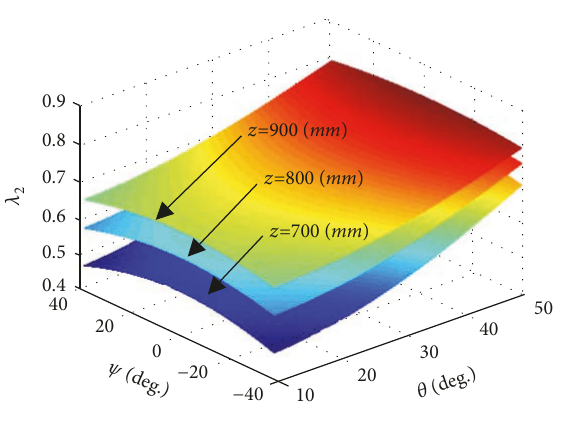
Figure 14: Output efficiency coefficient of the limb